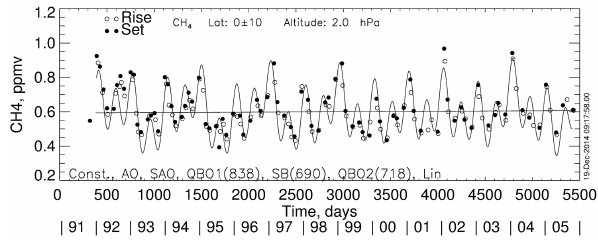
Figure 10. Time series of HALOE CH 4 at 2hPa at the tropical lati- tudes for comparison with that of Nedoluha et al.